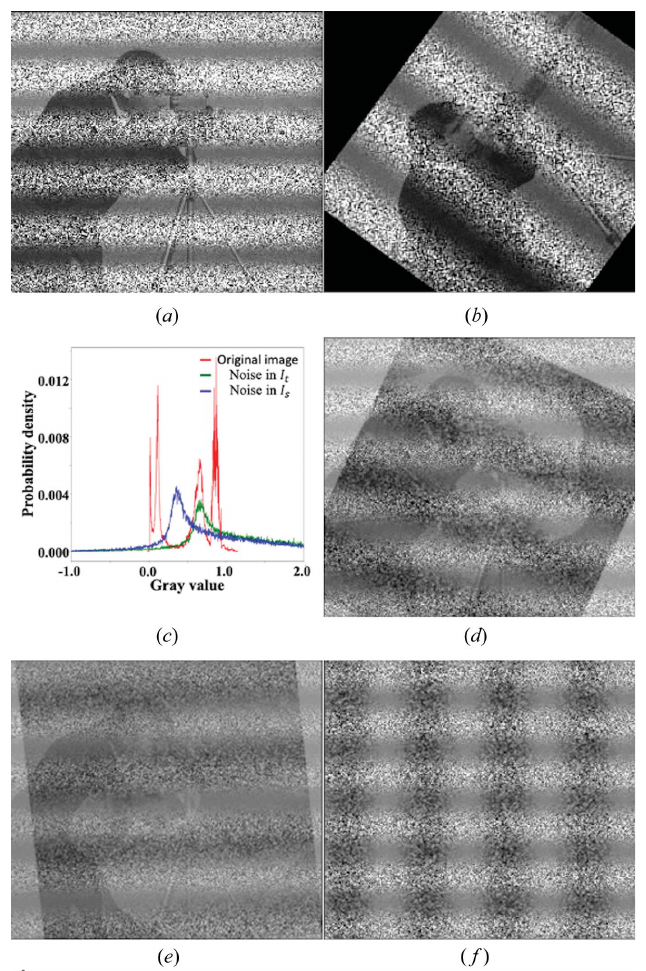
Figure 4 Images used in experiment 2 and results. Panels ( a ) and ( b ) show the synthesized target and source images. ( c ) Histograms of the original image Fig. 3( a ) and additive noises in ( a ) and ( b ). ( d )–( f ) Difference images between ( a ) and the registered images with FPC, SSD and TVDM.